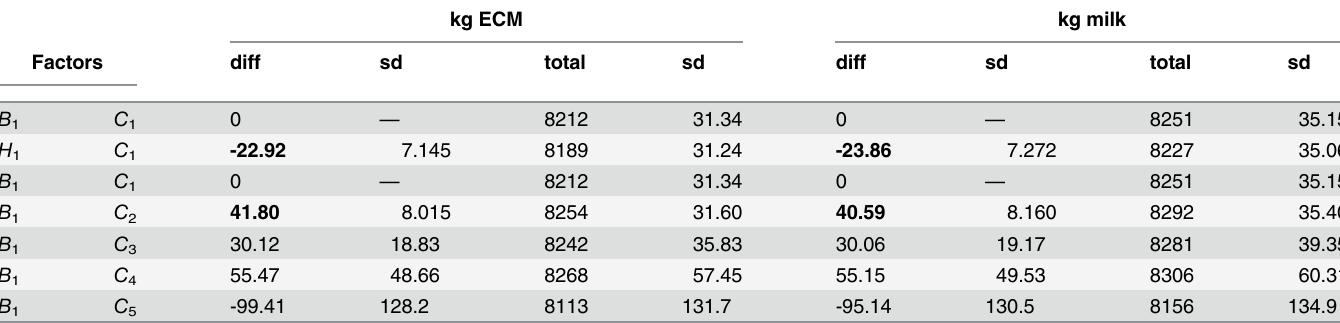
Table 4. Milk production in parity one, best model. kg ECM kg